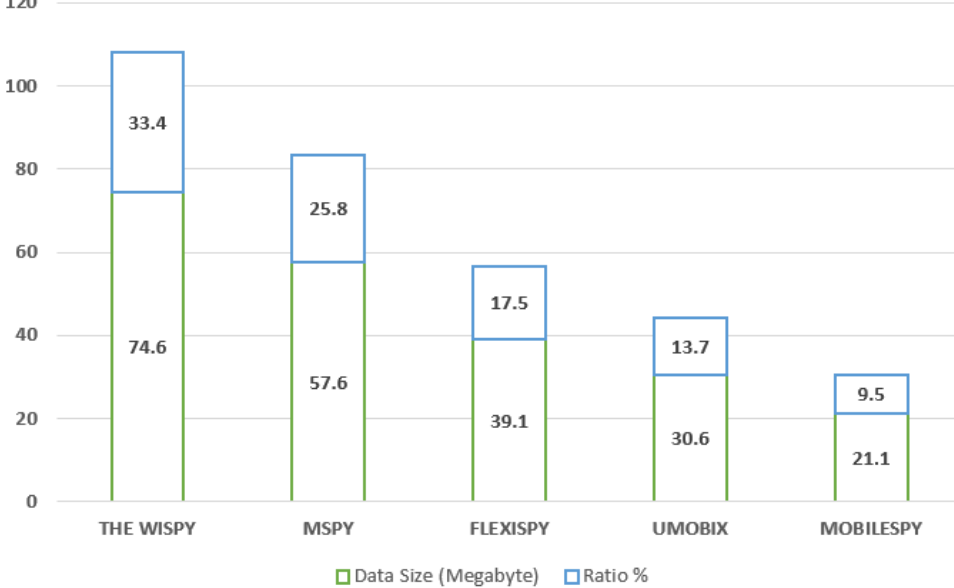
Figure 3. Data distribution and volume. Table 6. Network protocol distribution according to